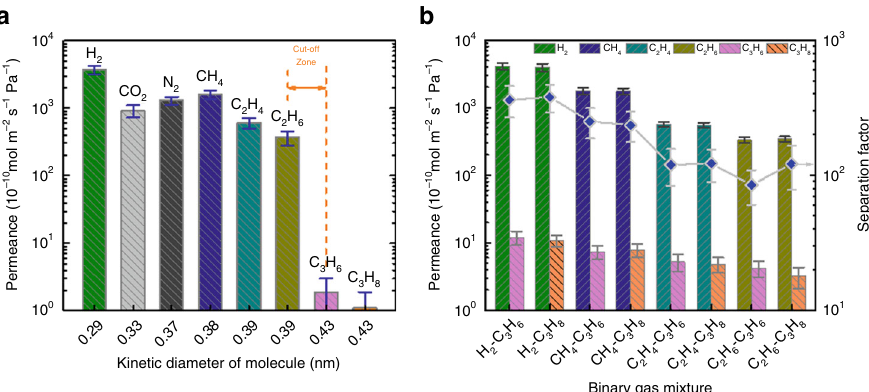
Fig. 5 Gas permeation performance of ED-GO@PSSHF composite membrane. a Single-gas measurements of small gas molecules and light hydrocarbons permeation through ED-GO@PSSHF membrane ( Δ P = 2 bar and room temperature) and b separation performance of ED-GO@PSSHF membrane for binary gas mixtures (The volume ratio of mixture is 1:1, Δ P = 2 bar and room temperature); error bars derived from SD